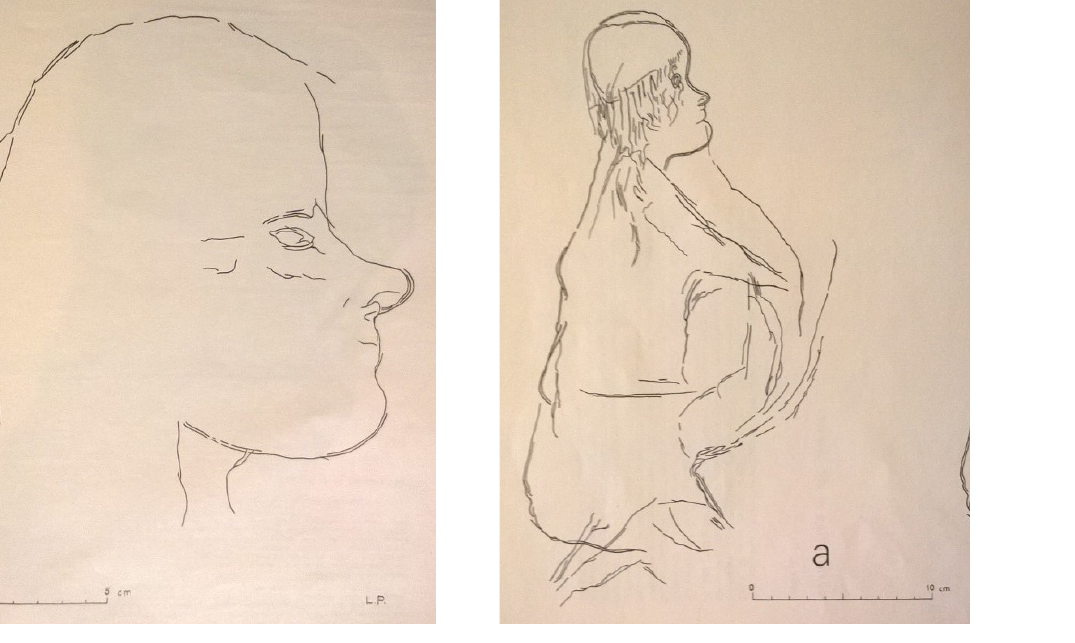
Figure 7. Group α, examples of Hand α1: Obs. 43(I) (from Pales, 1976).